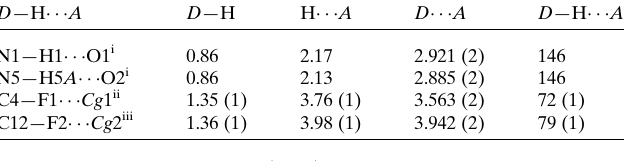
Table 1 Hydrogen-bond geometry (A˚ , (cid:3) ).